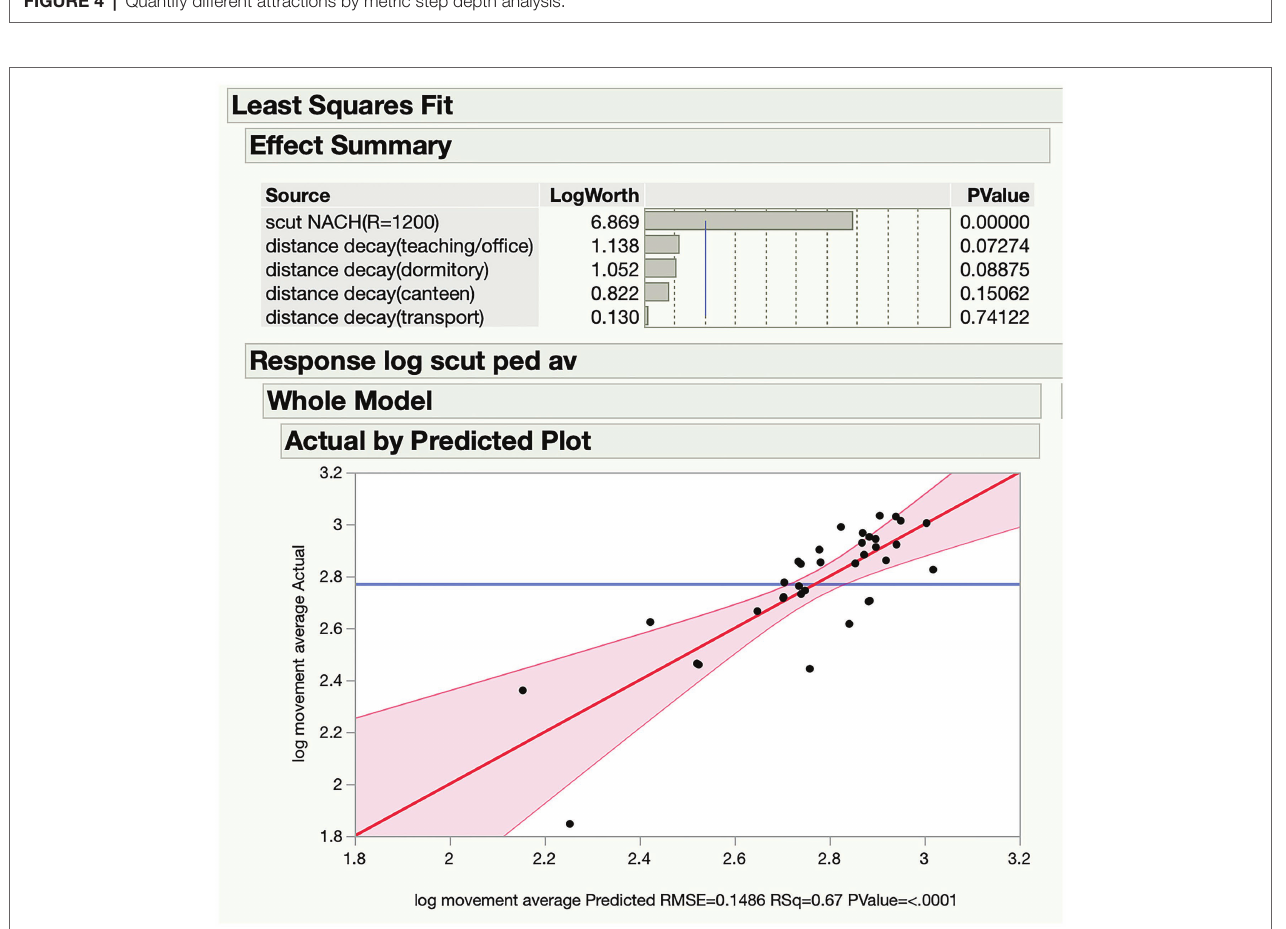
FIGURE 5 | Multiple variable regression analysis in